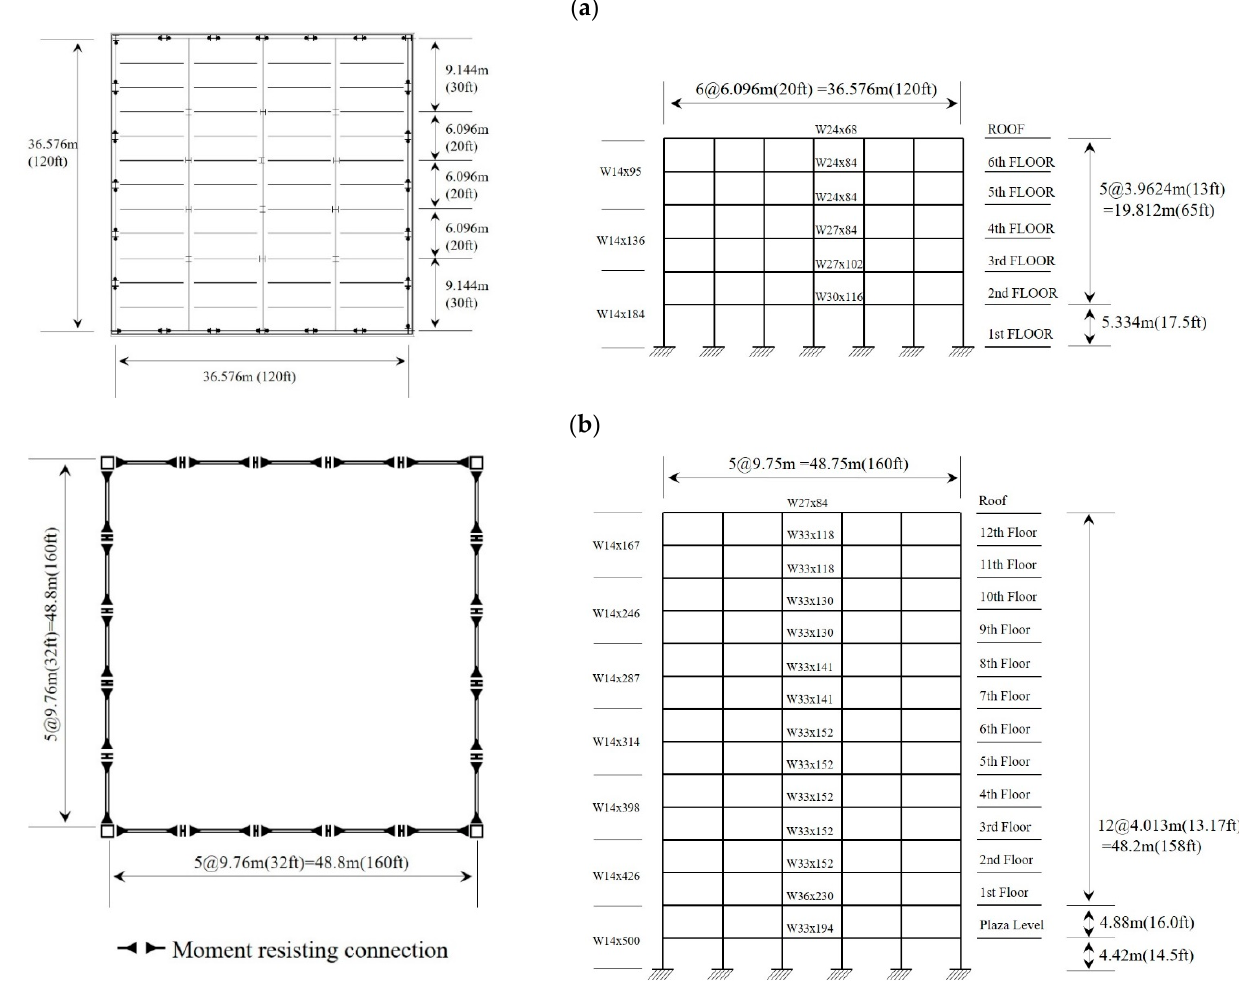
Figure 3. Structural configuration based on floor plan view and elevation view for the ( a ) six-floor building and ( b ) 13-floor building.